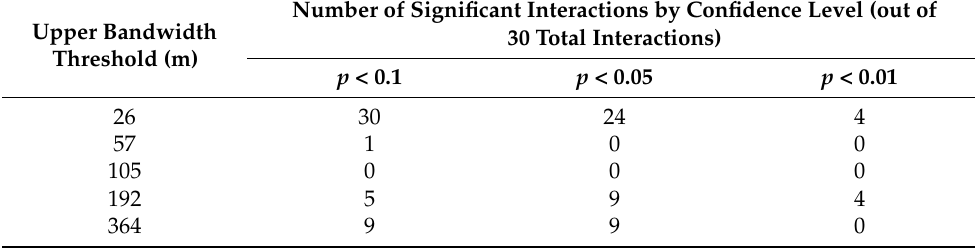
Table 4. Per-month significant accidents’ interactions by spatial threshold and probability